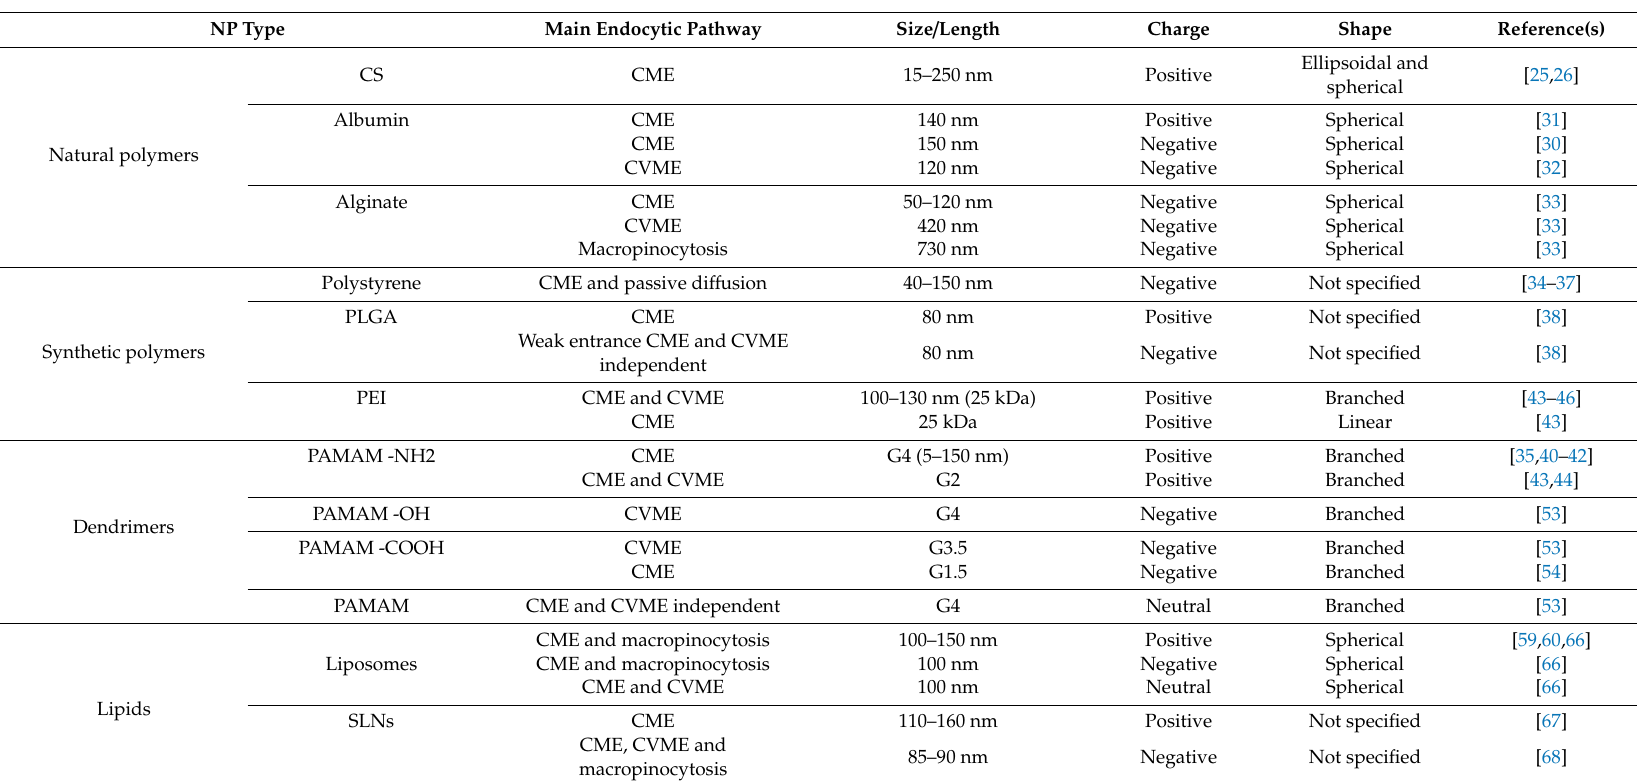
Table 1. Main endocytosis pathways for every nanoparticle (NP) kind described in this review article, considering factors as size, charge, or